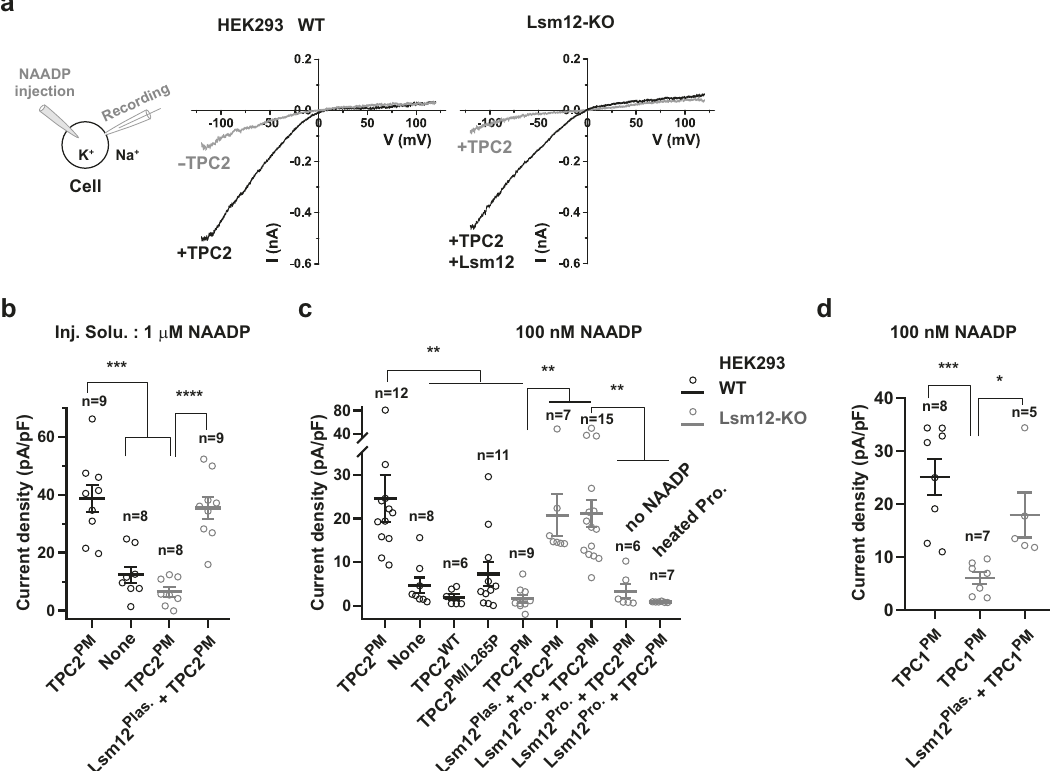
Fig. 6 Lsm12 is required for TPC activation by NAADP. a Averaged traces of NAADP (1 μ M in pipette solution) microinjection-induced whole-cell currents (averaged) in HEK293 WT and Lsm12-KO cells transfected with/without TPC2 L11A/L12A and Lsm12. b – d Averaged current density of NAADP microinjection-induced whole-cell TPC2 ( b , c ) and TPC1 ( d ) currents in HEK293 WT and Lsm12-KO cells. The cells (WT shown in black and Lsm12-KO in gray) were transfected with/without Lsm12 plasmid (Lsm12 Plas. ) and plasmid of TPC2 WT (TPC2 WT ) or plasma membrane-targeted mutant (TPC2 PM or TPC1 PM ). NAADP was injected at 1 μ M ( b ) or 100 nM ( c , d ). The puri fi ed Lsm12 protein (Lsm12 Pro. in c ) was injected at ~100 ng/ µ l (~4 μ M) in